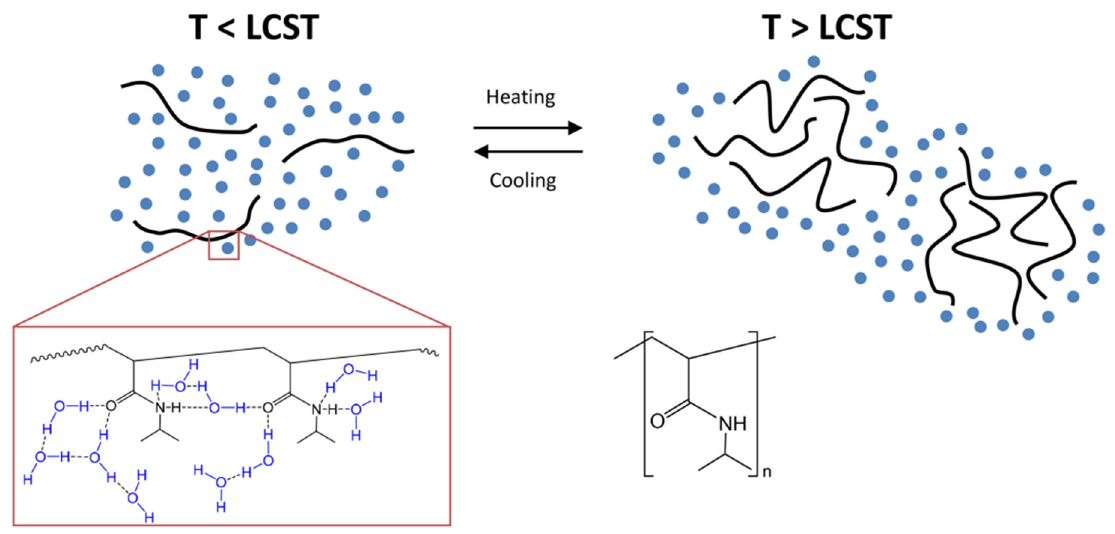
Figure 3. PNIPAAm chains (black) surrounded by water molecules (blue) as a function of temperature. Bottom-right: chemical structure of PNIPAAm. The red inset shows the possible hydrogen bonds between water molecules and polymer chains. Below the LCST, polymer chains are fully hydrated and solubilized, whereas above the LCST, they interact strongly with one another, the intrachain hydrophobic effect changes the conformation of the polymer chains to a coil state, they aggregate, and phase separate from the water phase to yield a turbid suspension. Reproduced from Bordat et al. [94] with kind permission of the copyright holder, 2019, Elsevier.